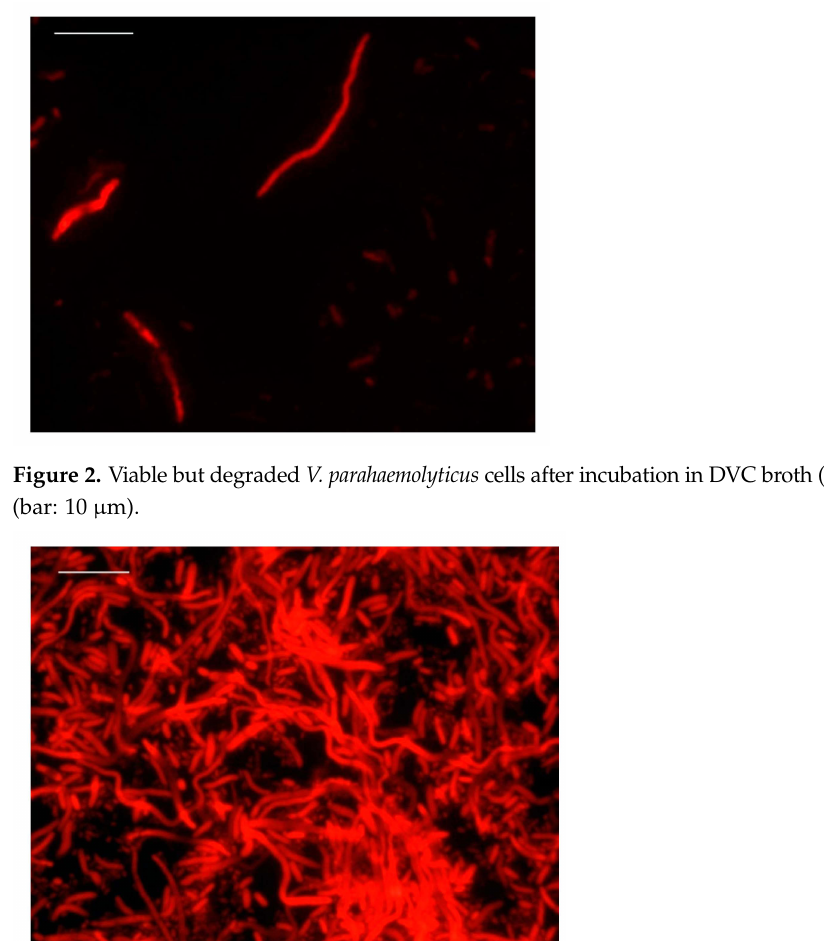
Figure 3. Detection by FISH of live and dead cells of V. parahaemolyticus after 5 h incubation with ciprofloxacin (0.75 µ g/mL). (bar: 10 µ m).